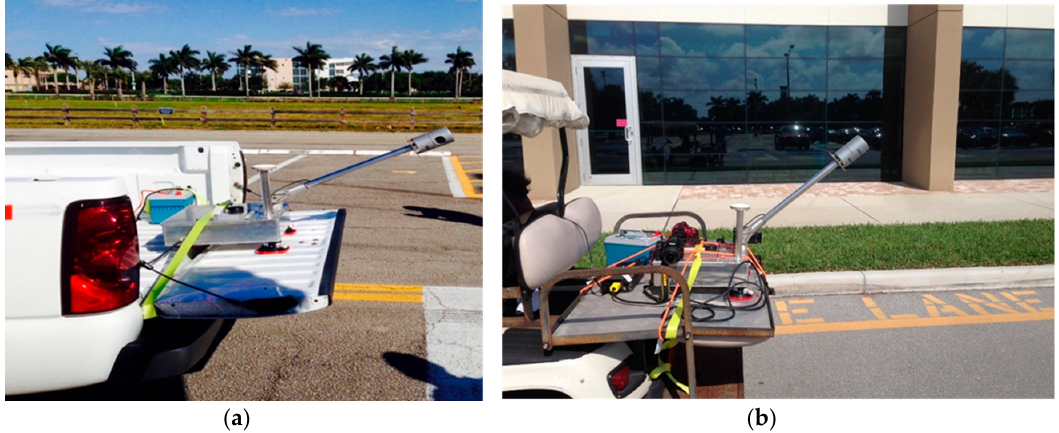
Figure 3. Mobile mapping system mounted on a truck ( a ) and a golf cart ( b ) for data collection.